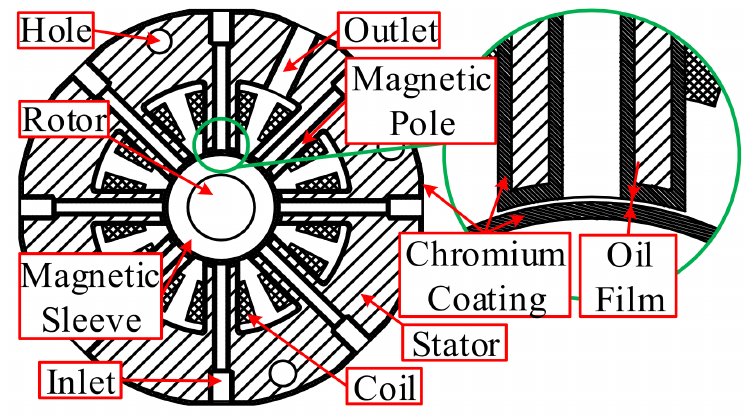
Figure 2. Sectional view of radial unit of MLDSB.